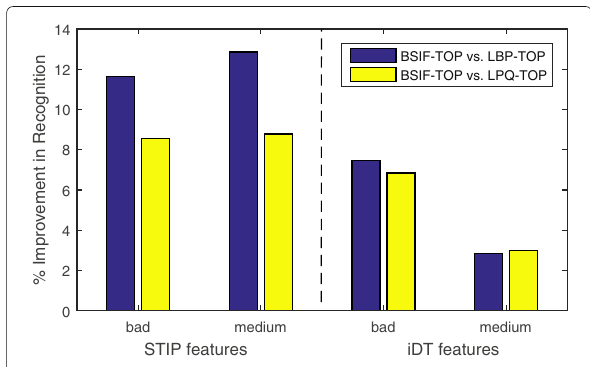
Fig. 10 Percentage improvement of BSIF-TOP over LBP-TOP and LPQ-TOP, when combined with interest point based features on